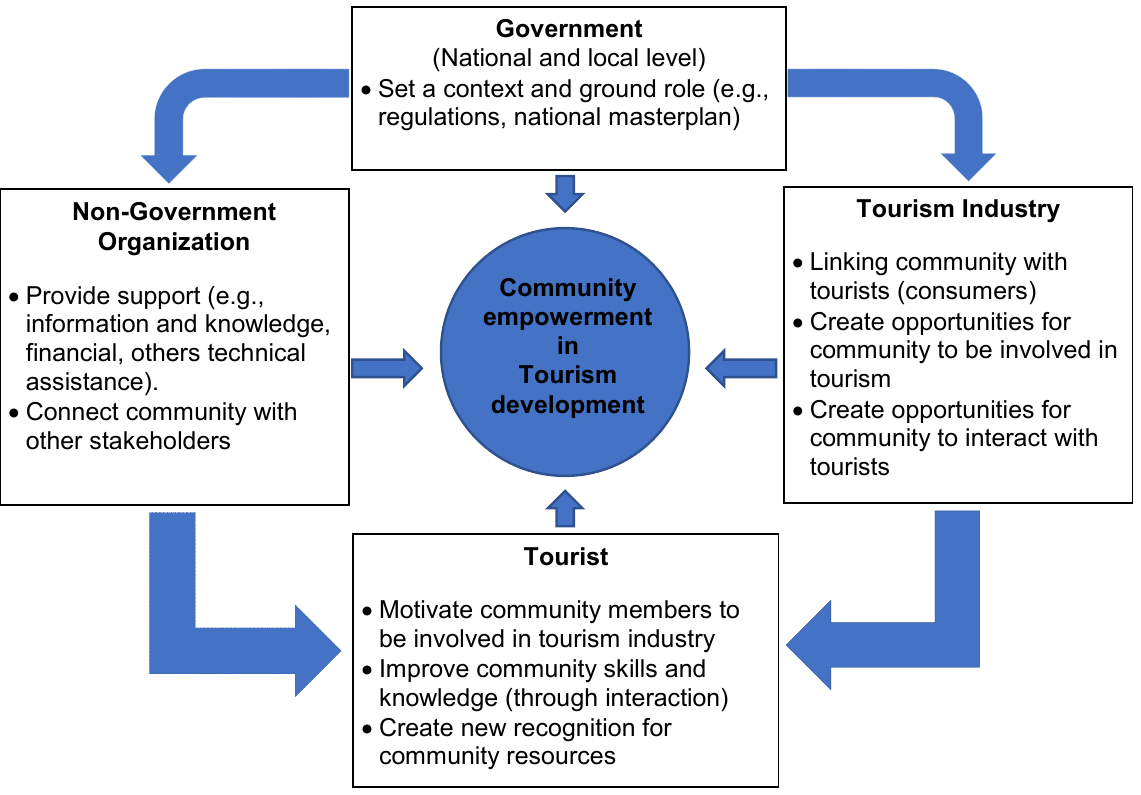
Figure 1. Tourism stakeholder’s role in community